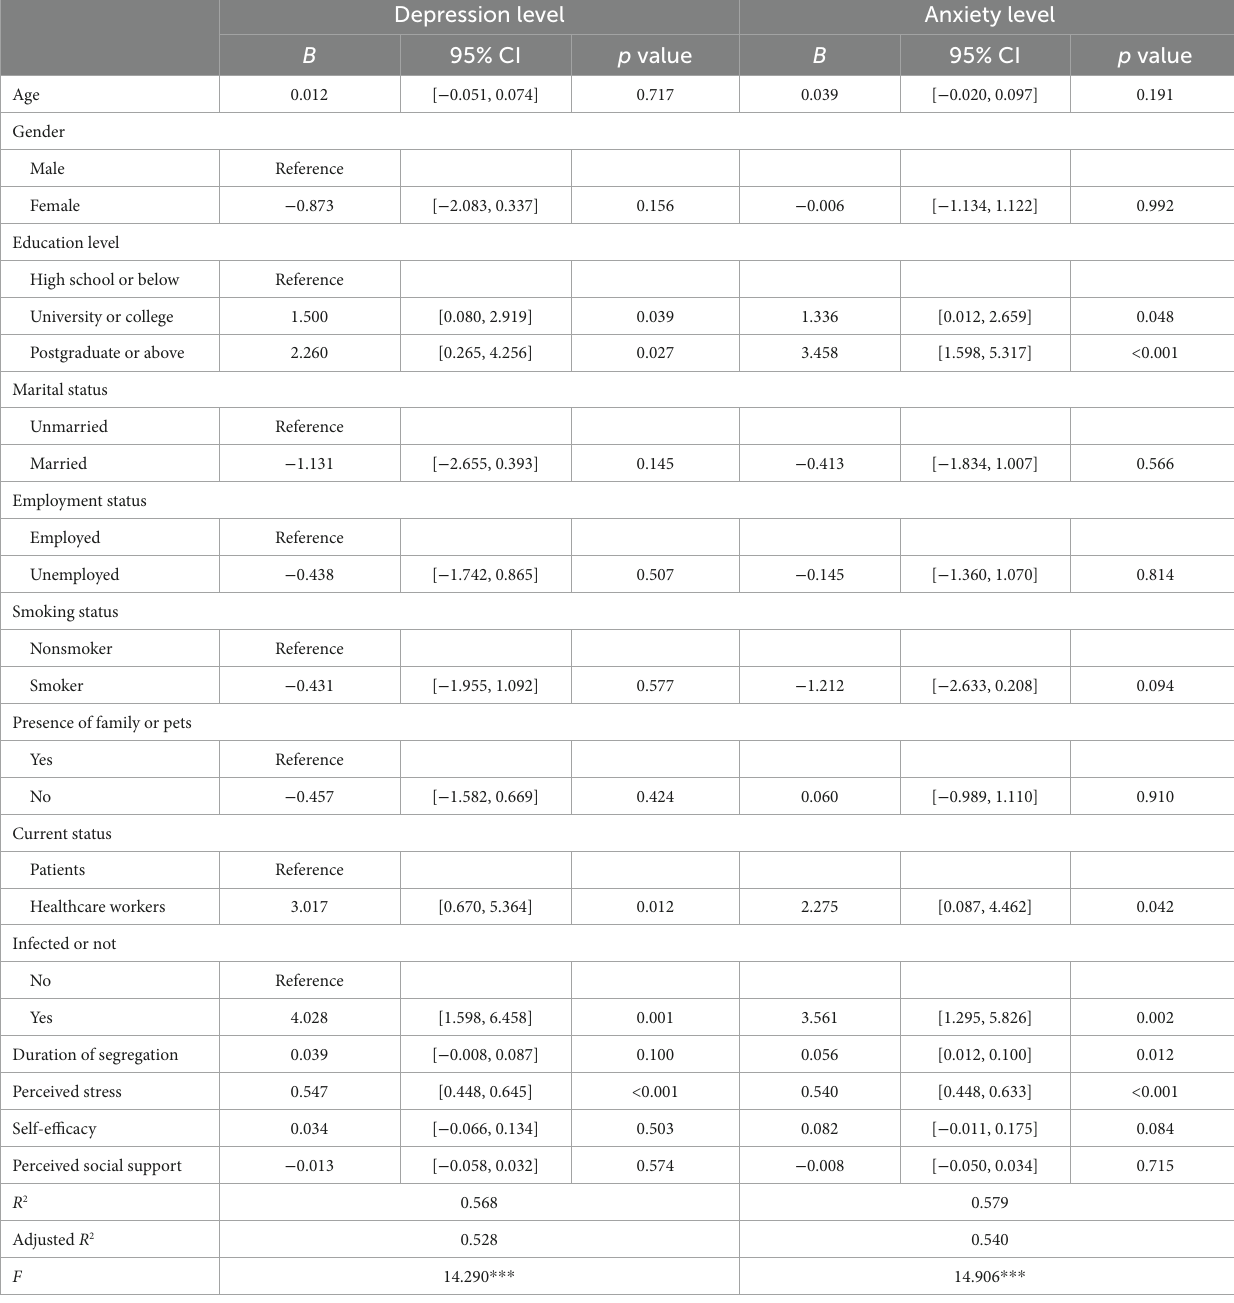
TABLE 3 Multiple linear regression analysis of associated factors for depression and anxiety